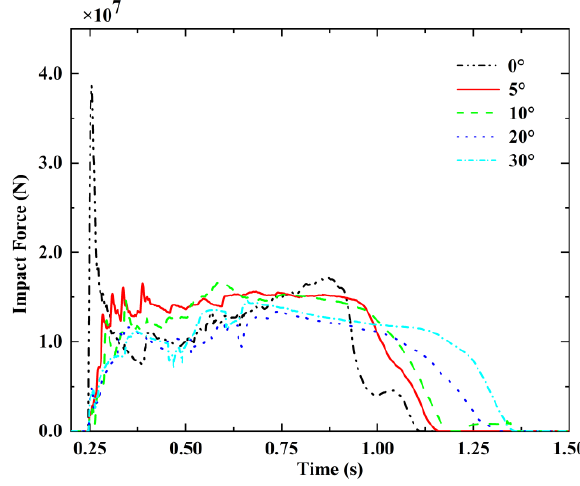
Figure 15. Comparison of impact forces at different impact angles.